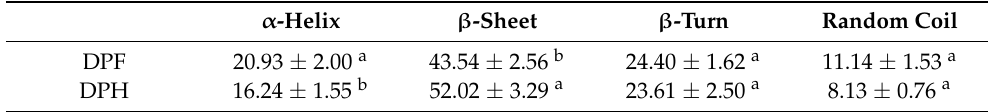
Table 2. Protein secondary structures of DPF and DPH.